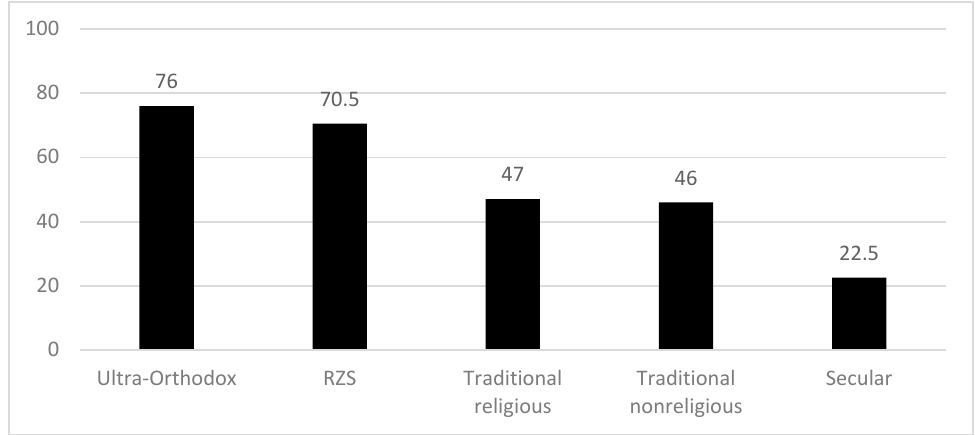
Figure 17. Agree that the Supreme Court has too much power, by level of religiosity (%) Source: Israeli Democracy Index, 2021.